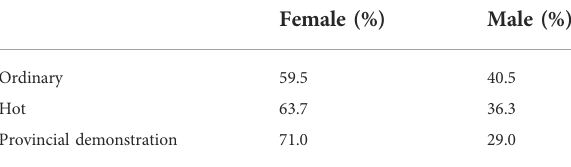
TABLE 3 Gender differences in the percentage of kid